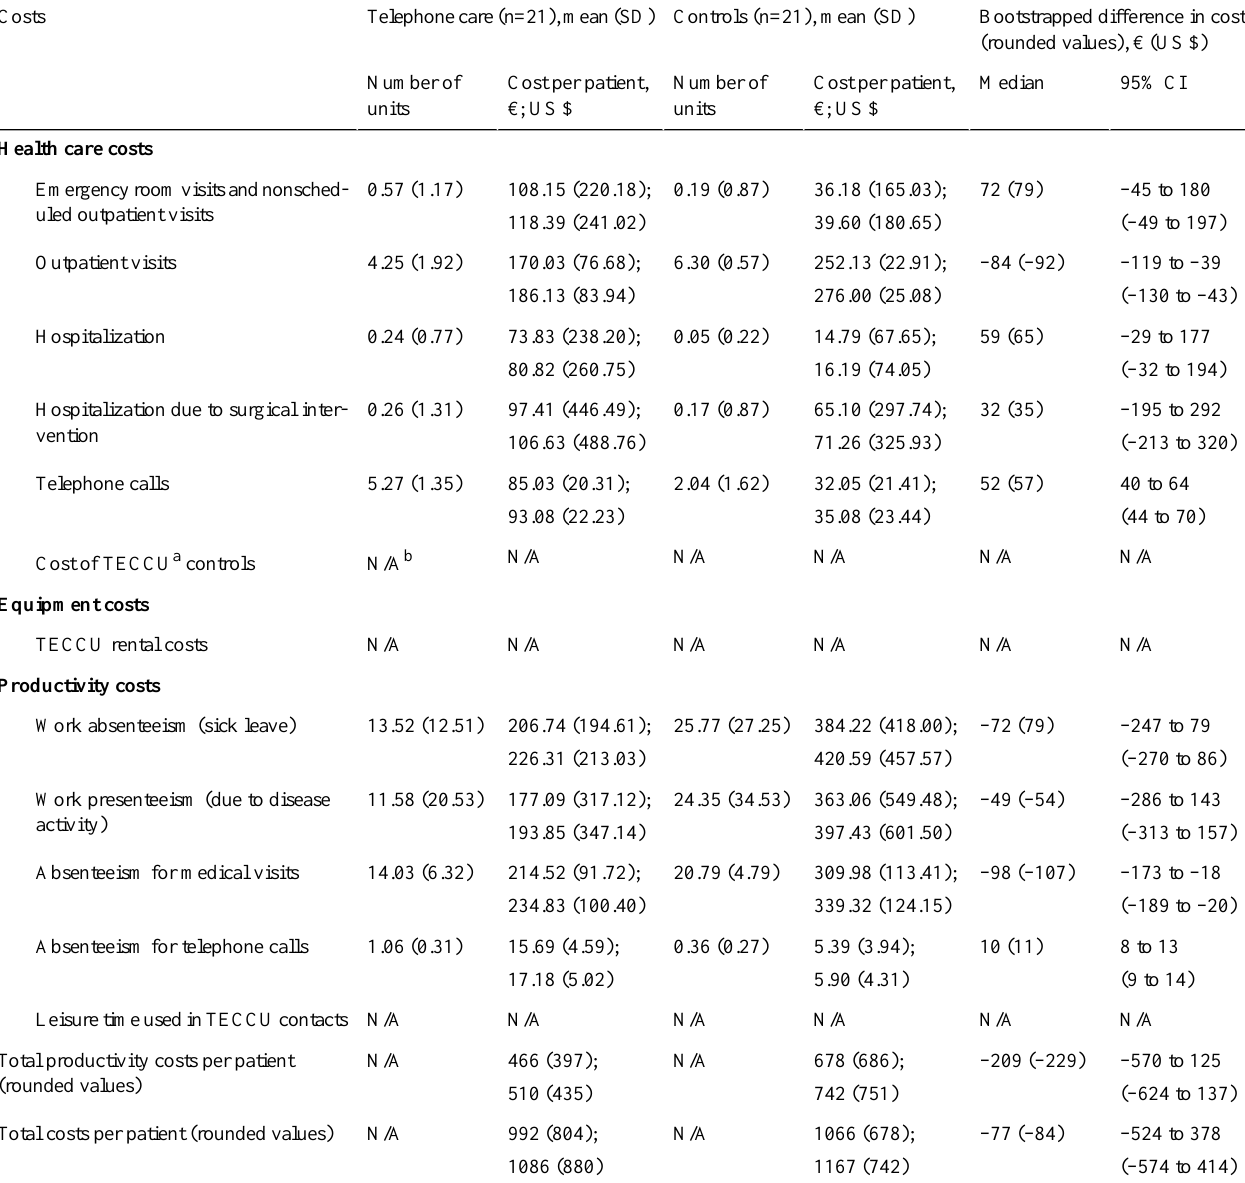
Table 7. Costs per patient in the group receiving nurse-assisted telephone care (G_NT) vs standard care (G_control).